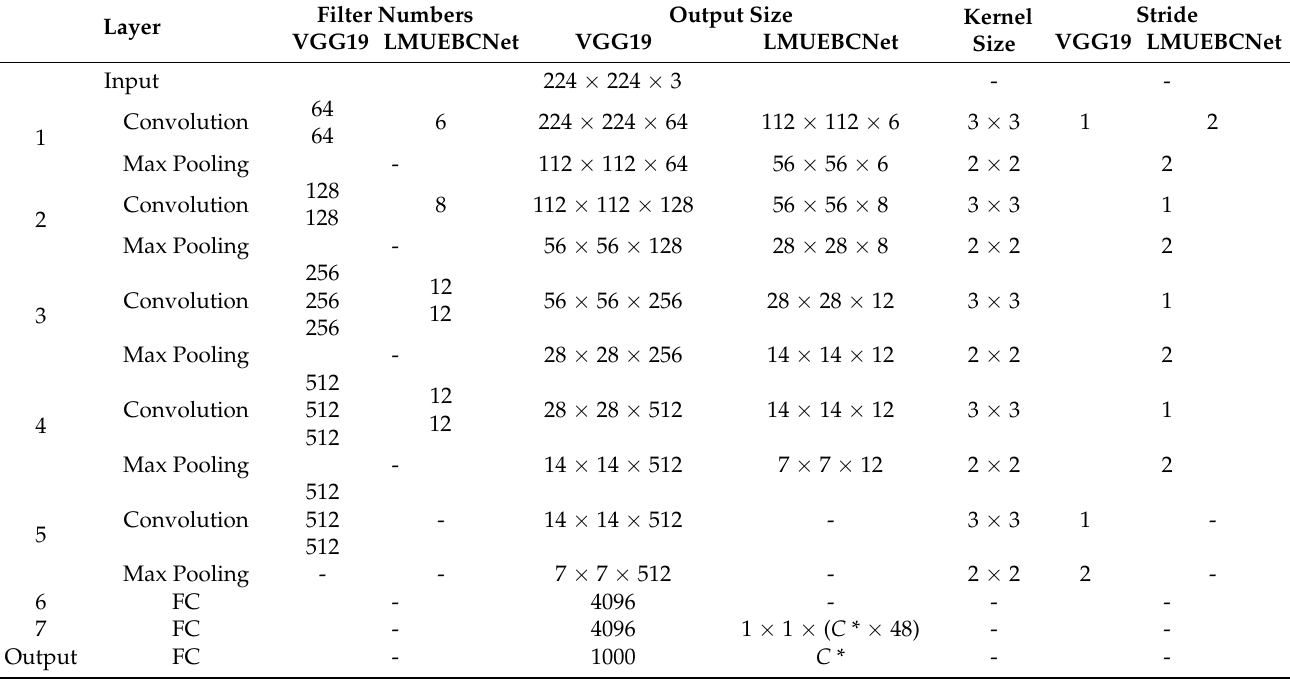
Table 1. Proposed LMUEBCNet architecture compared with VGG19